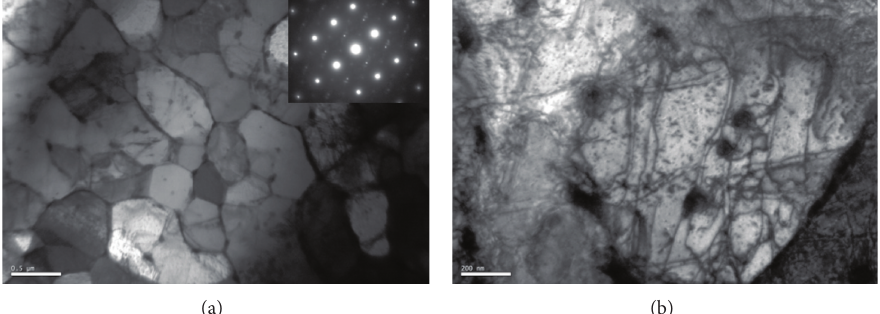
Figure 4: TEM of rapidly quenched ribbons: (a) bright field microstructure of the ribbon with diffraction pattern inset and (b) substructure of the ribbon showing super dislocations.